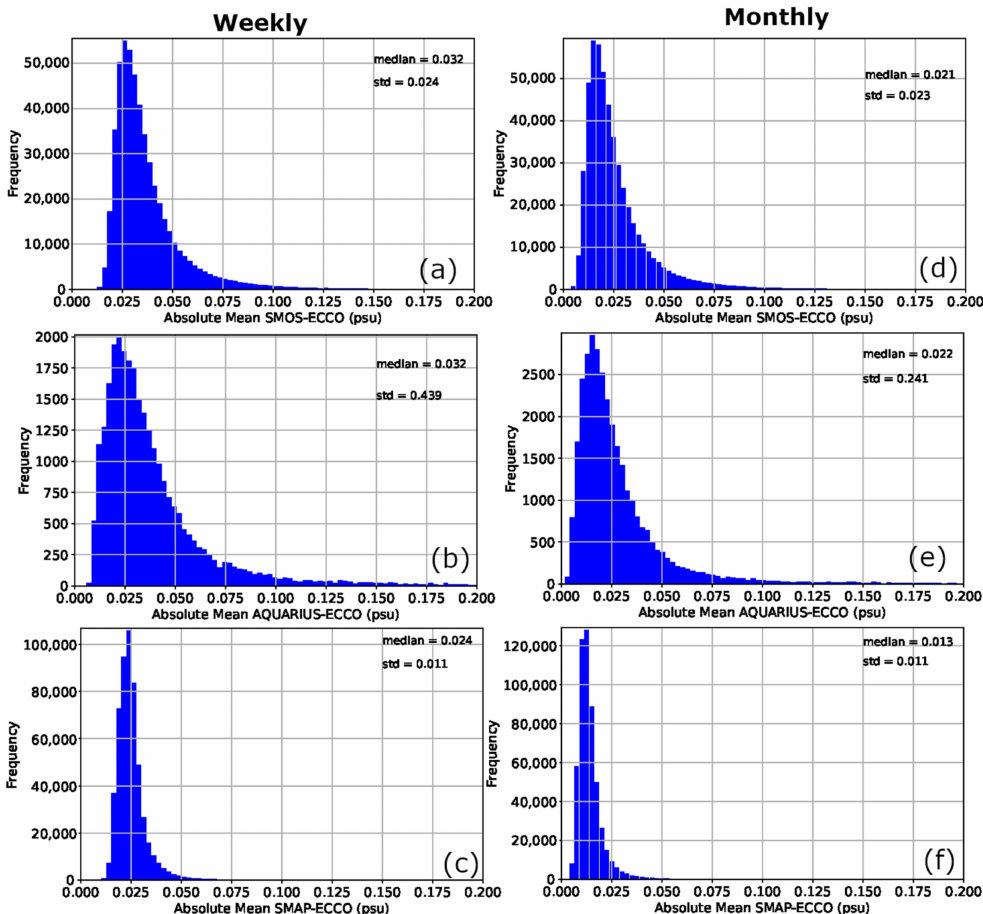
Figure 6. Histograms of the absolute differences between our monthly/weekly ground truth (ECCO model) and ( a , d ) SMOS, ( b , e ) Aquarius, and ( c , f ) SMAP SSS with a normally distributed noise with zero mean and a standard deviation of 0.1